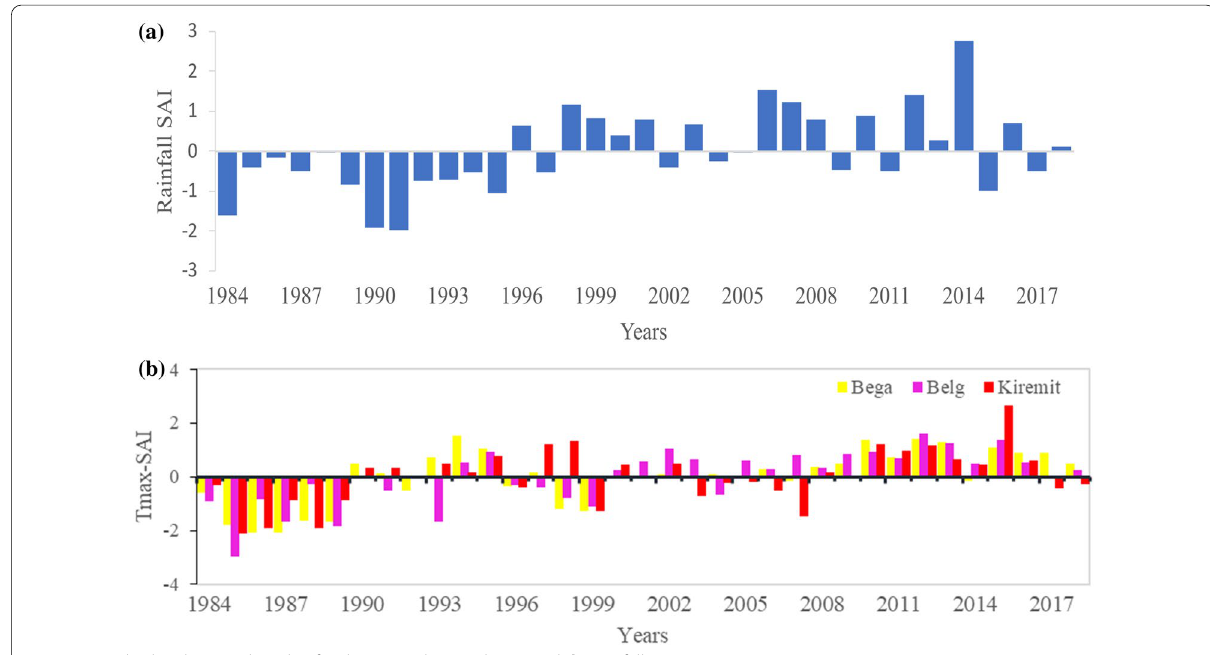
Fig. 8 Standardized anomaly index for the Annual ( a ) and seasonal ( b )